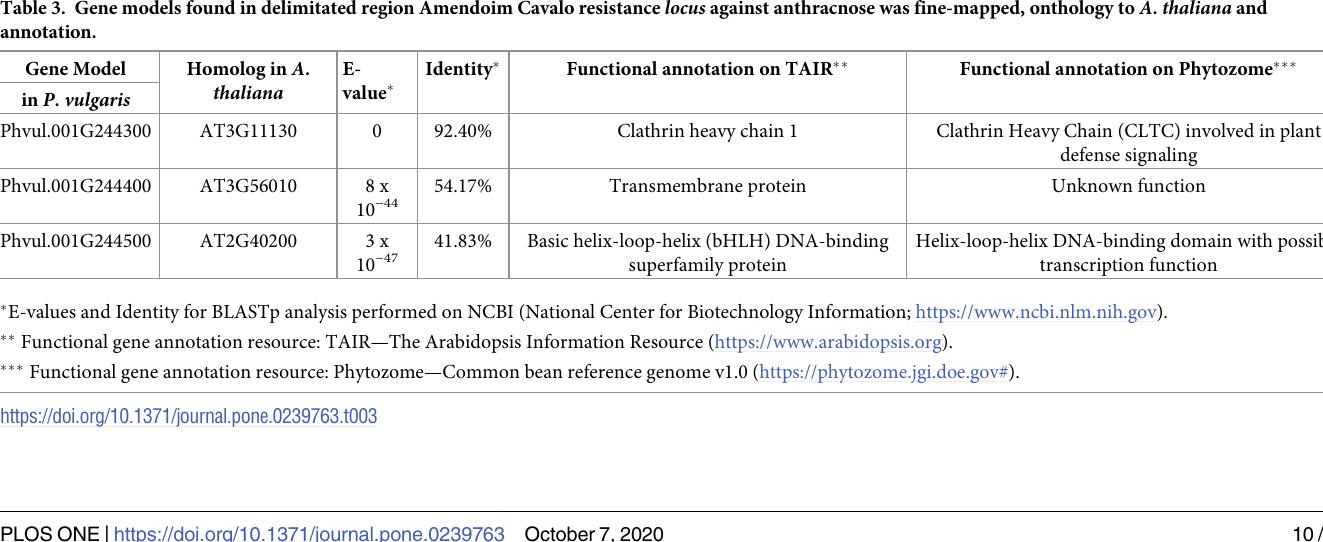
Table 3. Gene models found in delimitated region Amendoim Cavalo resistance locus against anthracnose was fine-mapped, onthology to A . thaliana and annotation. Gene Model Homolog in A .